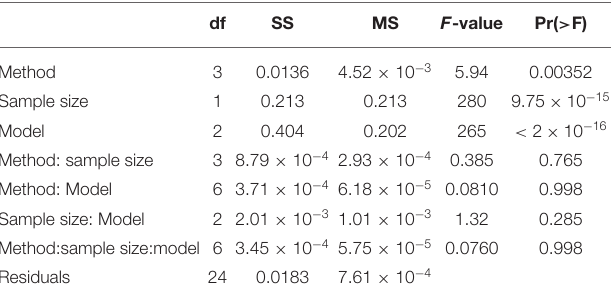
TABLE 3 | ANOVA table showing the importance of the statistical model, sample size and training set selection method and interactions for the prediction accuracies of tuber length (TT Scheme).